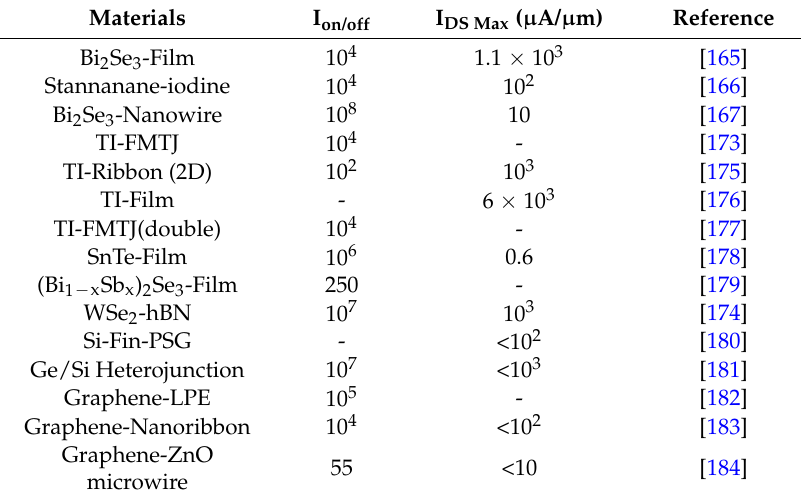
Table 5. Comparison of different